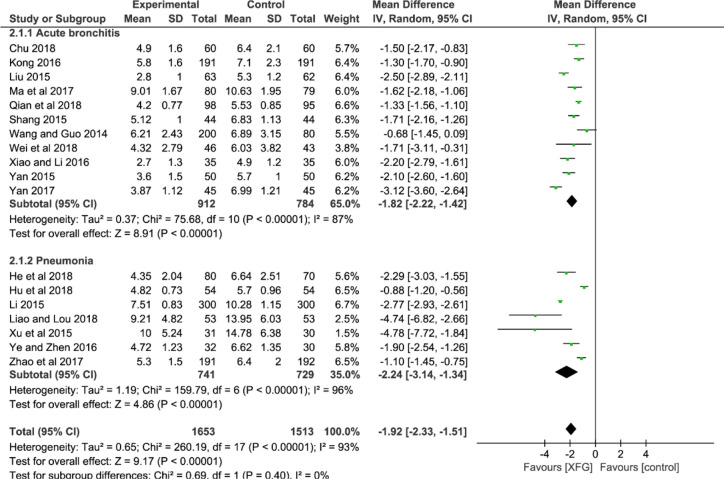
Forest plot and subgroup analysis of the RTC.